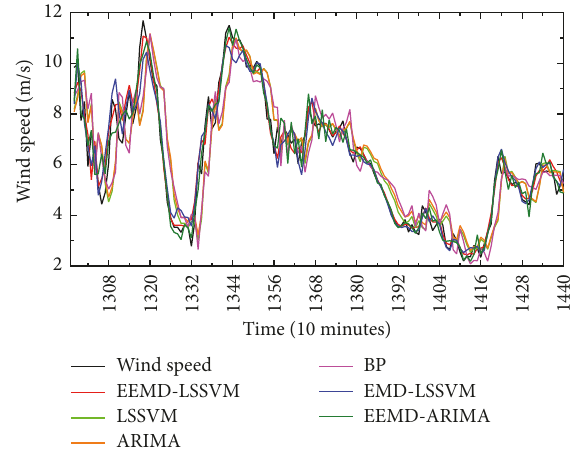
Figure 7: Two-step-ahead forecasting results (Case One).